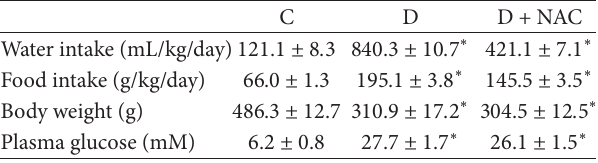
Table 1: General Characteristics of Rats at the End of the Study.